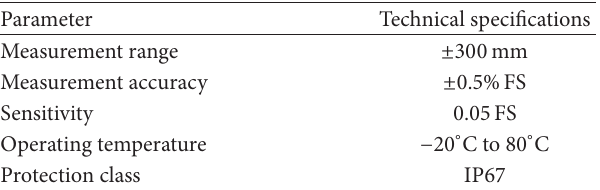
Table 5: Technical specifications of the hydrostatic level gauge.